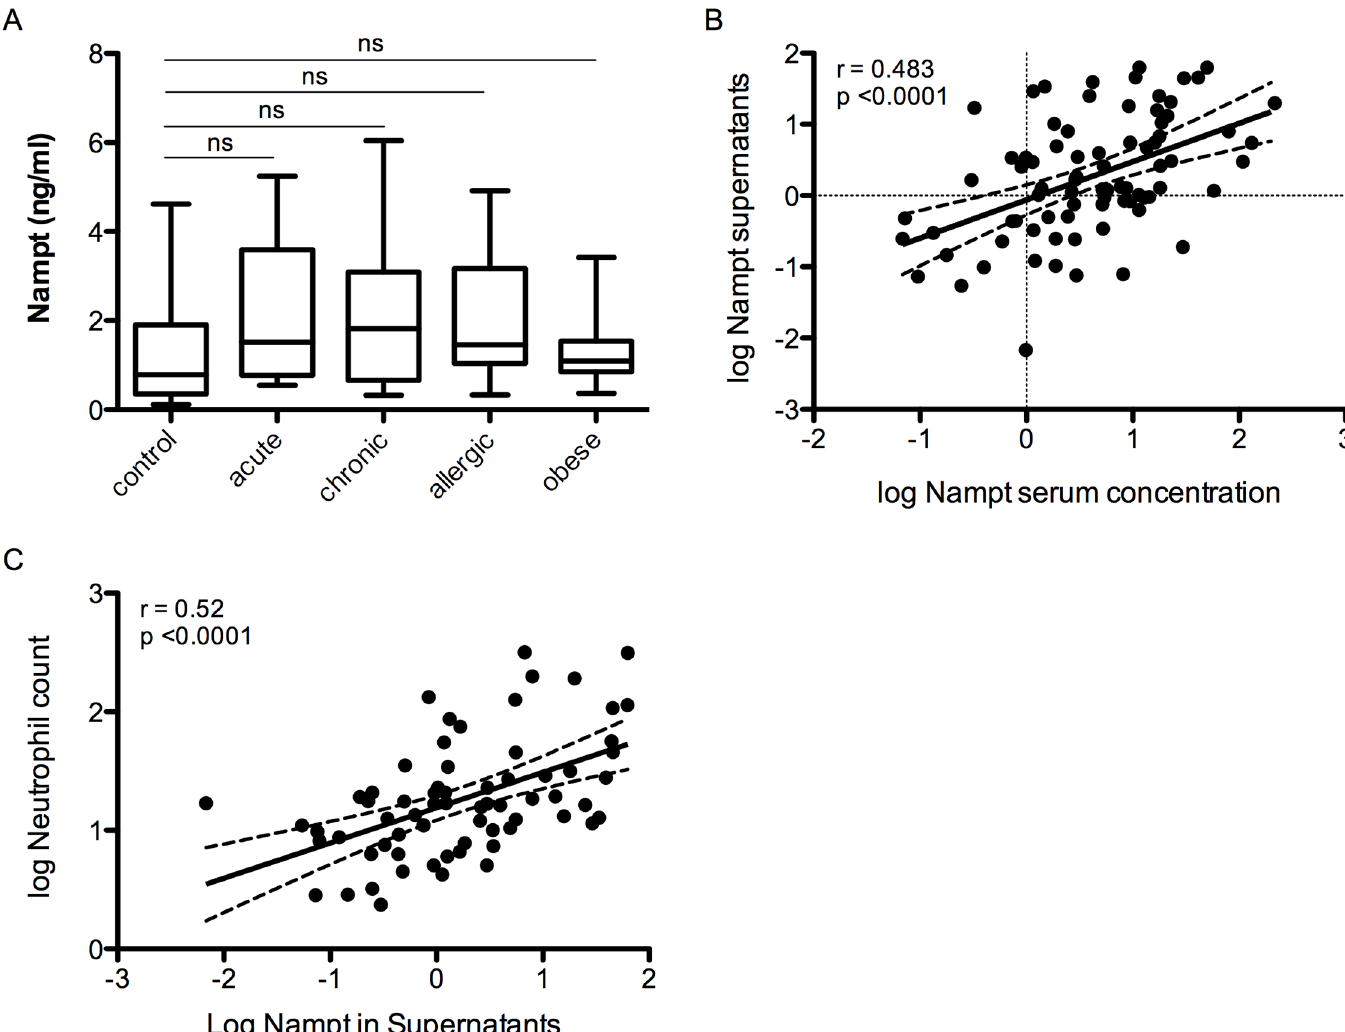
Fig 3. NAMPT releasefrom PBMCs. Comparisonof NAMPT release betweenpatient groupsof distinct inflammatory conditions and controls (A). Boxes are interquartile range, whiskersare minimumto maximum. Statistical significancewas assessedby ANOVA and Tukey HSD test. Correlation betweenlog NAMPT serum concentrations and corresponding NAMPT release from PBMCs of the same patient (B) and Correlation betweenNAMPT release from PBMCs with blood neutrophilcounts (C).